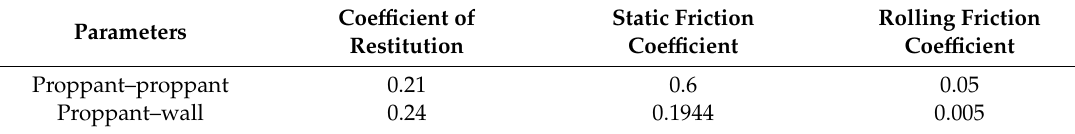
Table 6. The interaction parameters between proppant and fracture wall.